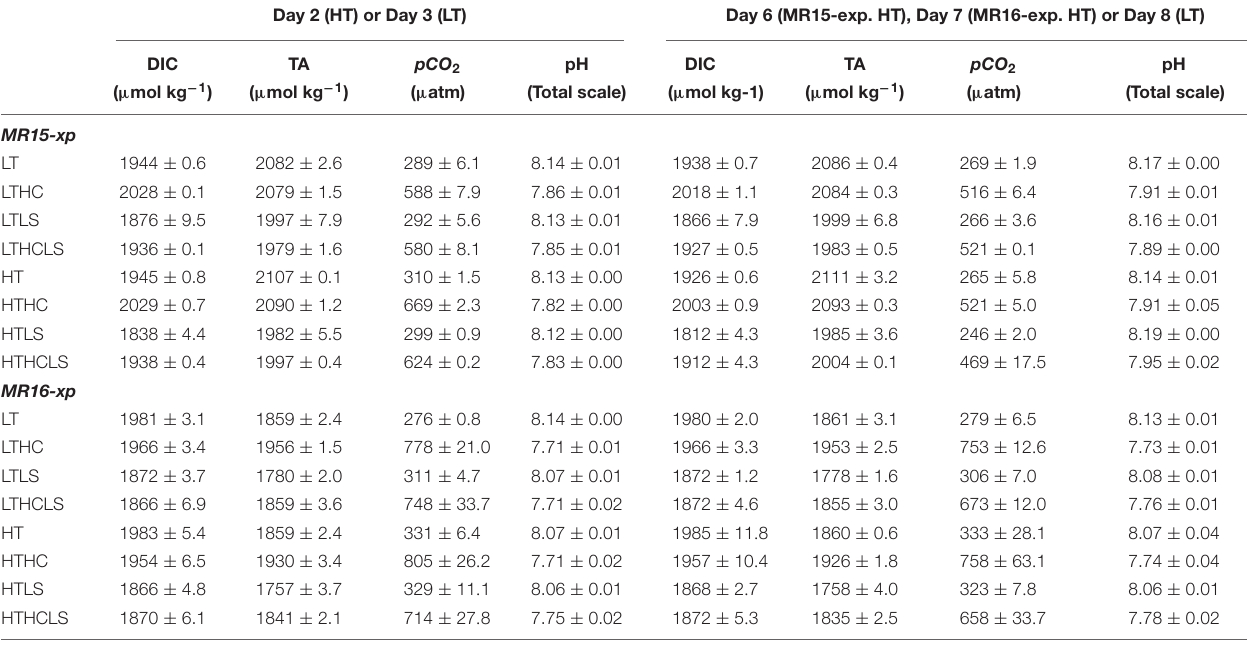
TABLE 1 | Results of carbonate chemistry during the two experiments. LT and HT represent low- and high-temperature treatment,